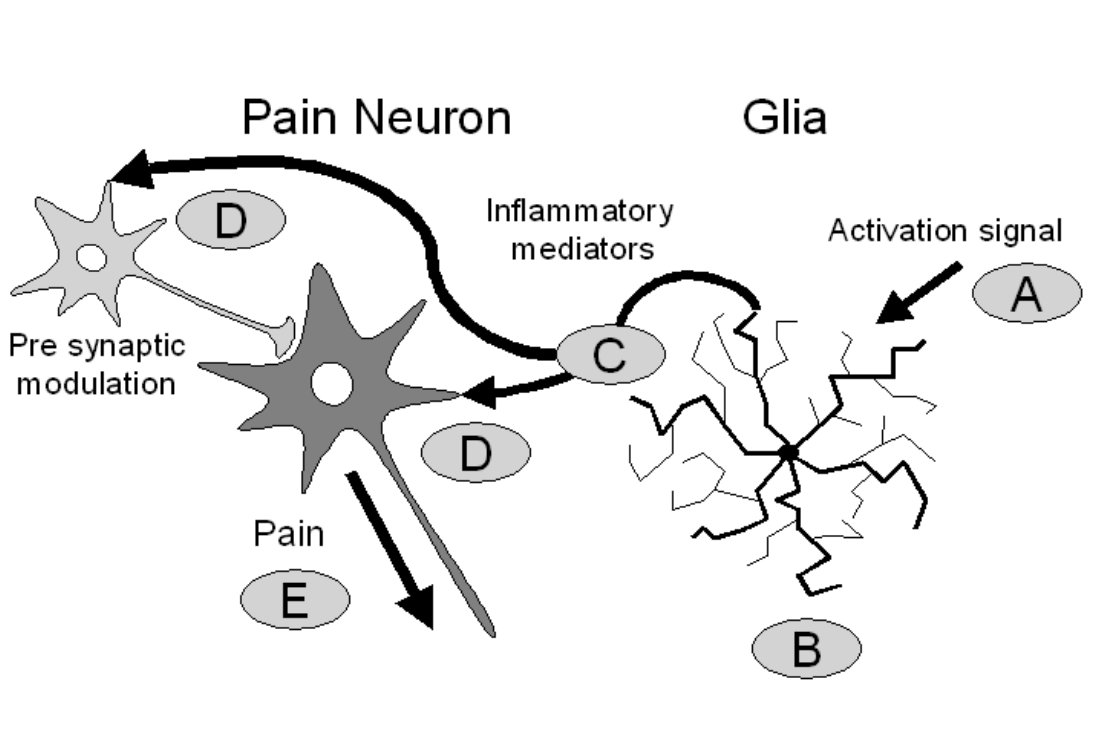
FIGURE 1. Schematic of neuropathic pain, highlighting theoretical points (A–E) where pharmacological targets can be designed to treat neuropathic pain to which glia importantly contribute. Step A: An activation or series of activation signals are required to activate glia often mediated via cell surface receptors that can be antagonized. Step B: Glial activation is an all-encompassing term we use for the state in which glia release proinflammatory mediators. This state can be modulated or attenuated, thereby inhibiting various cellular events that block glial activation or its downstream consequences. An anti-inflammatory environment can also be produced, which increases the threshold that an activation signal has to overcome to activate the cells. Step C: Immune inflammatory mediators, such as proinflammatory cytokines, can be neutralized prior to reaching their intended receptor target (pre- and/or postsynaptic) by using soluble receptors (which exist endogenously), neutralizing antibodies, decreasing maturation of cytokines into their active form, or increasing the rate of cytokine degradation. Step D: The action of many glial inflammatory mediators on neurons (pre- and/or postsynaptic) can also be antagonized at neuronal receptor sites. Step E: Included here are the myriad